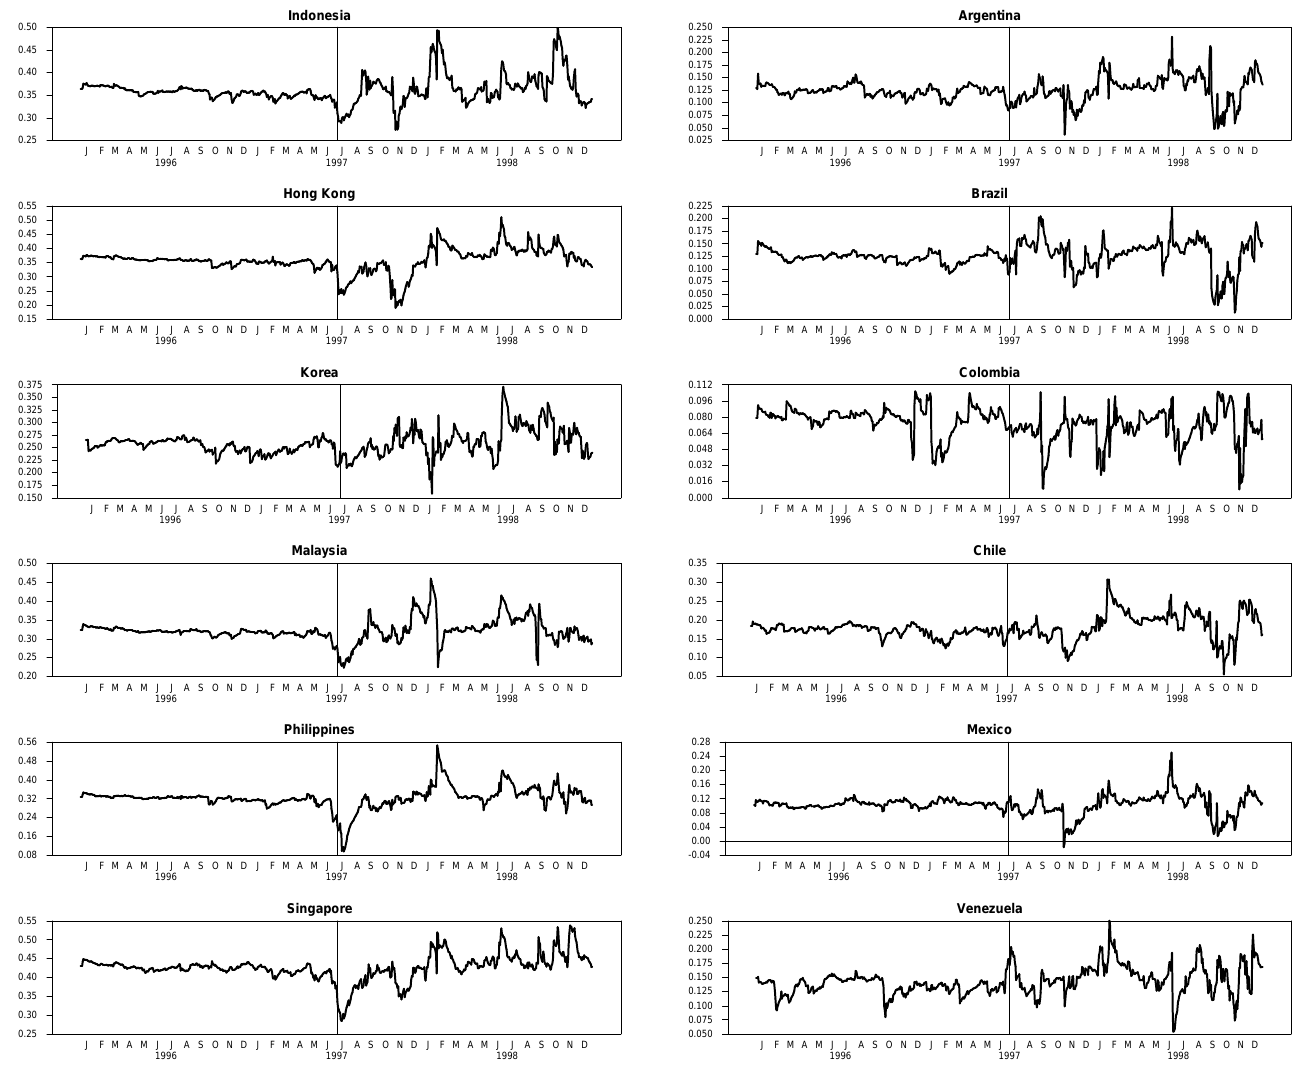
Figure 2. The dynamic correlation estimation for the Asian “flu” crisis (Source of contagion: Thailand). The vertical continuous line represents the break date: 2 July